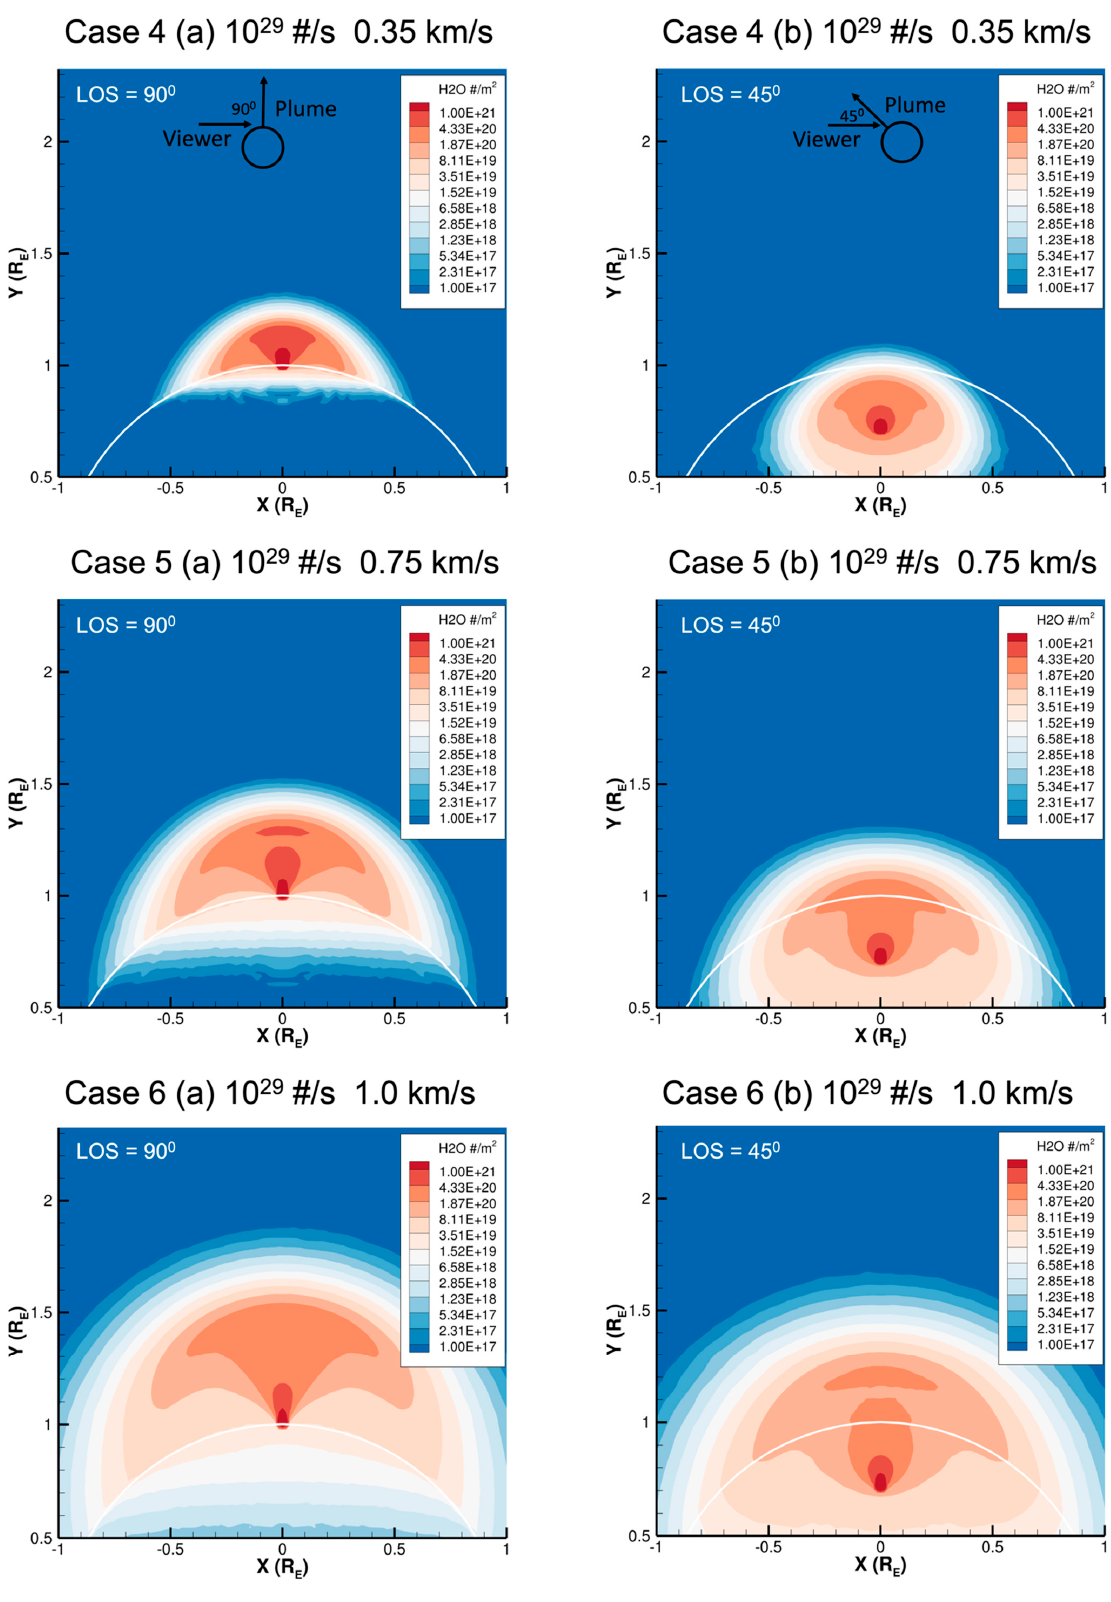
Figure 4. Column a ( Left ): Column density integrated along a line of sight of 90 degrees from Europa’s pole (i.e., perpendicular to the paper). The dashed, horizontal lines in case 1 represent four heights above the surface at 50, 100, 200 and 400 km. Column b ( Right ): Column density integrated along a line of sight of 45 degrees from Europa’s pole (i.e., toward the